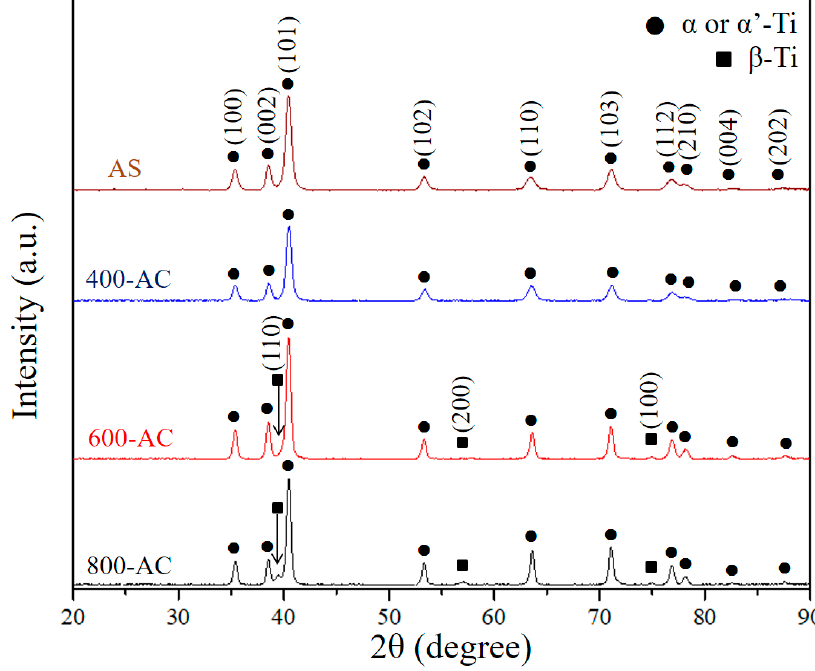
Figure 5. X-ray diffraction pattern of AS, 400-AC, 600-AC, and 800-AC specimens.